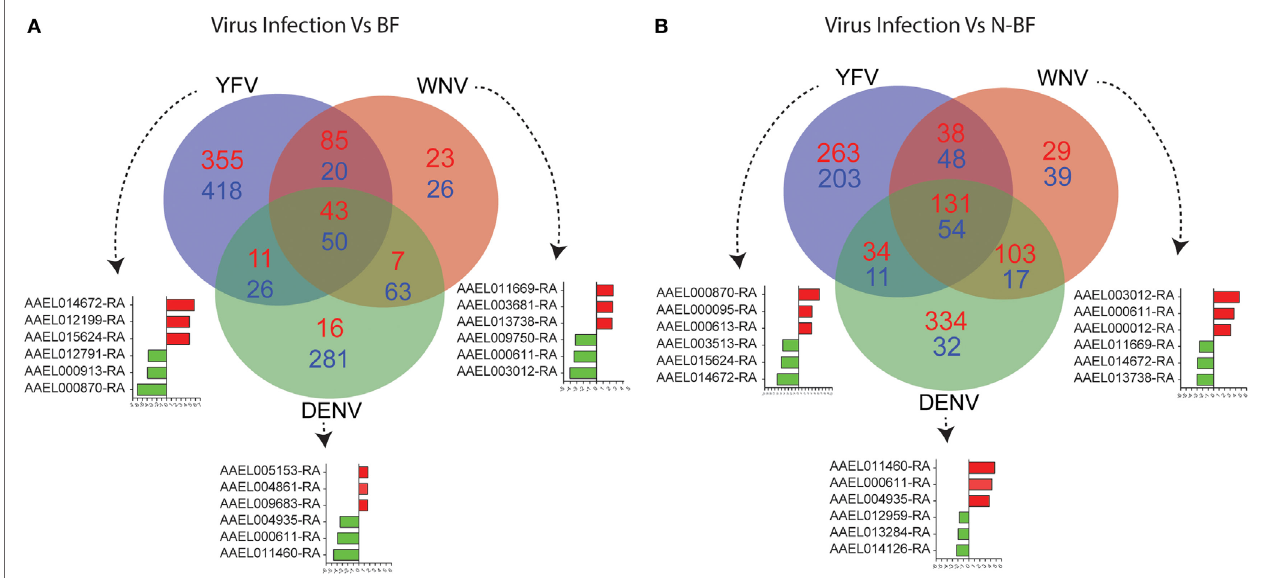
FigUre 2 | Critical signature differences in the distinct feeding schedules. (a) Differentially expressed genes (DEGs) from the comparison of genes from virus infected mosquitoes [yellow fever virus (YFV), dengue virus (DENV), and West Nile virus (WNV) vs. blood-fed (BF)]. (B) DEGs from the comparison of genes from virus infected mosquitoes (YFV, DENV, and WNV vs. non-BF). The blue numbers represent downregulated genes and the red numbers represent upregulated genes by absolute log 2 -transformed fold-change ≥ 1 criterium. Red and green bars correspond to up- and downregulated genes,